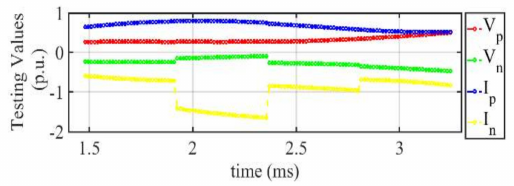
Figure 31. Testing values of the SVM algorithm under NPG fault.